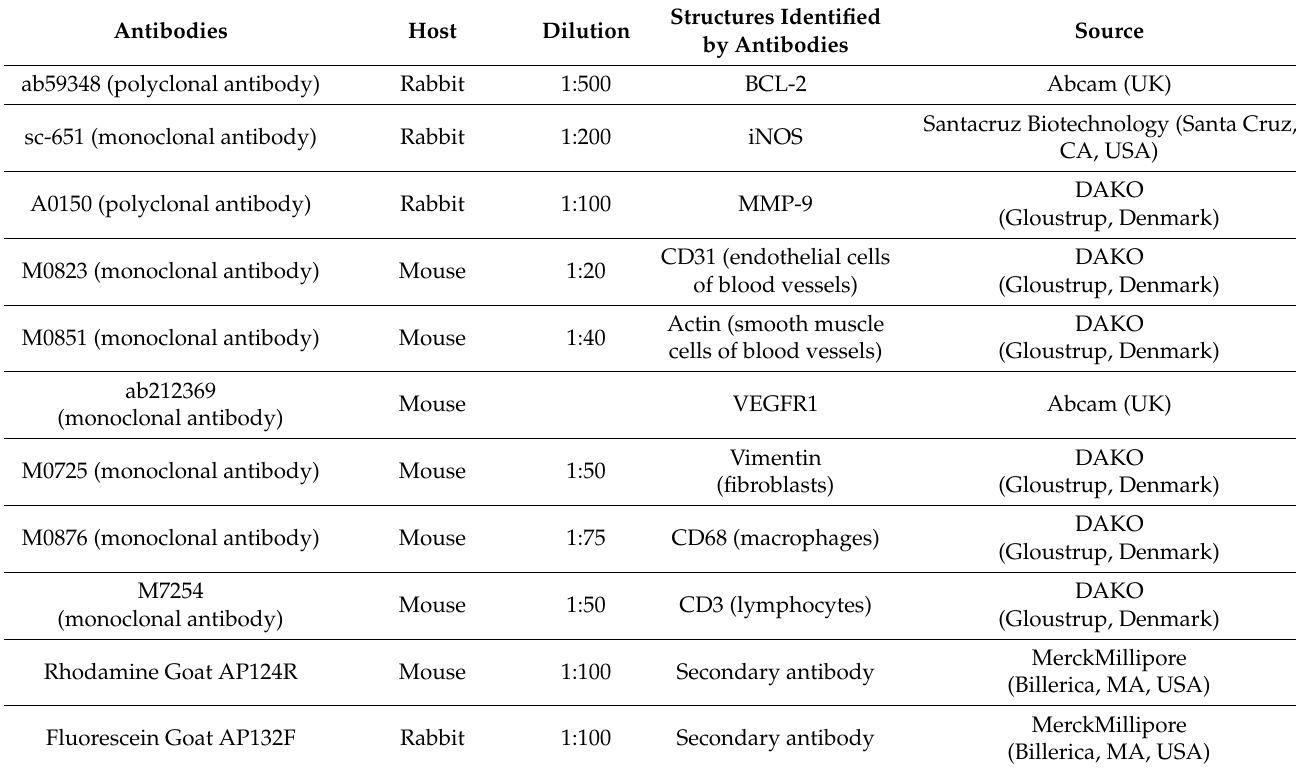
Table 4. Primary and secondary antibodies